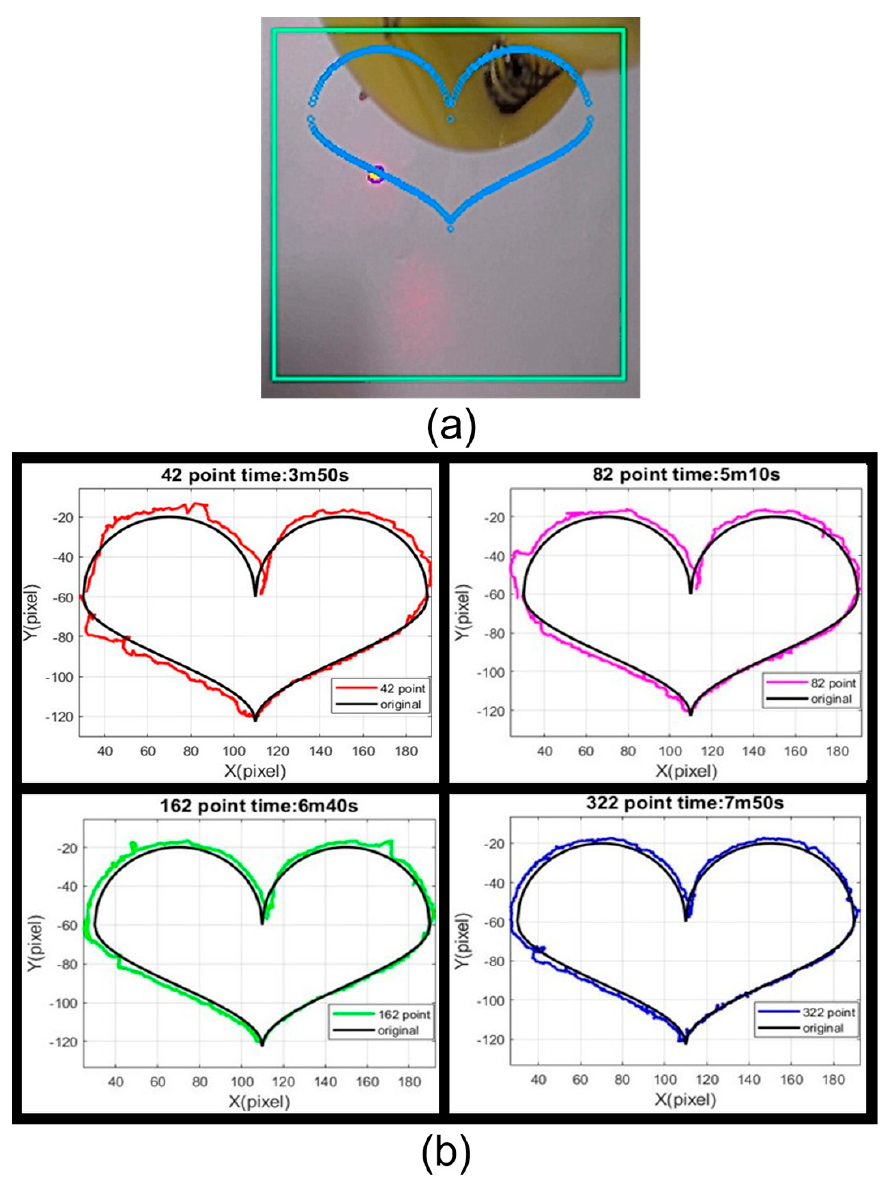
Figure 16. Heart shape trajectory tracking ( a ) Image obtained during trajectory tracking ( b ) Tracking trajectory with different numbers of tracking points.